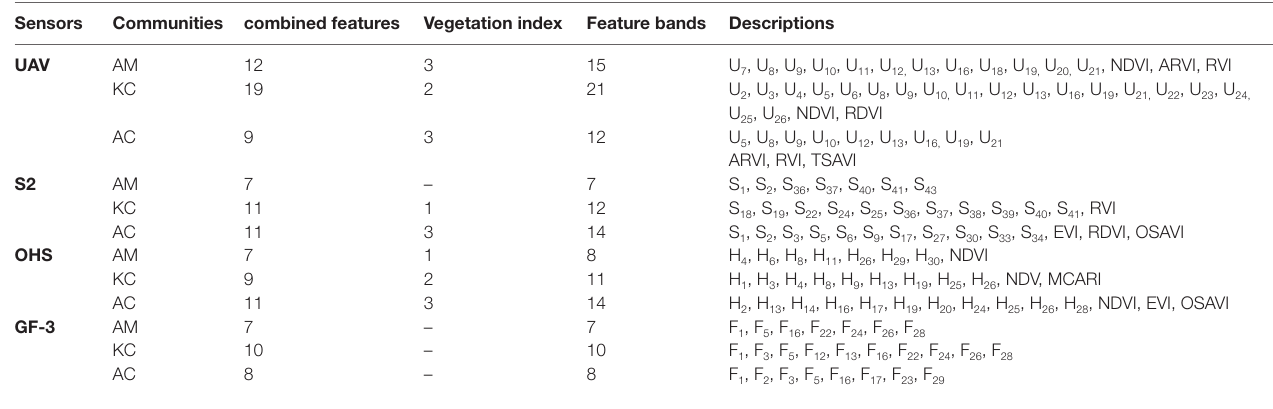
TABLE 4 | Preferred feature variables for mangrove LAI estimation from UAV, S2, OHS, and GF-3 SAR images. Sensors